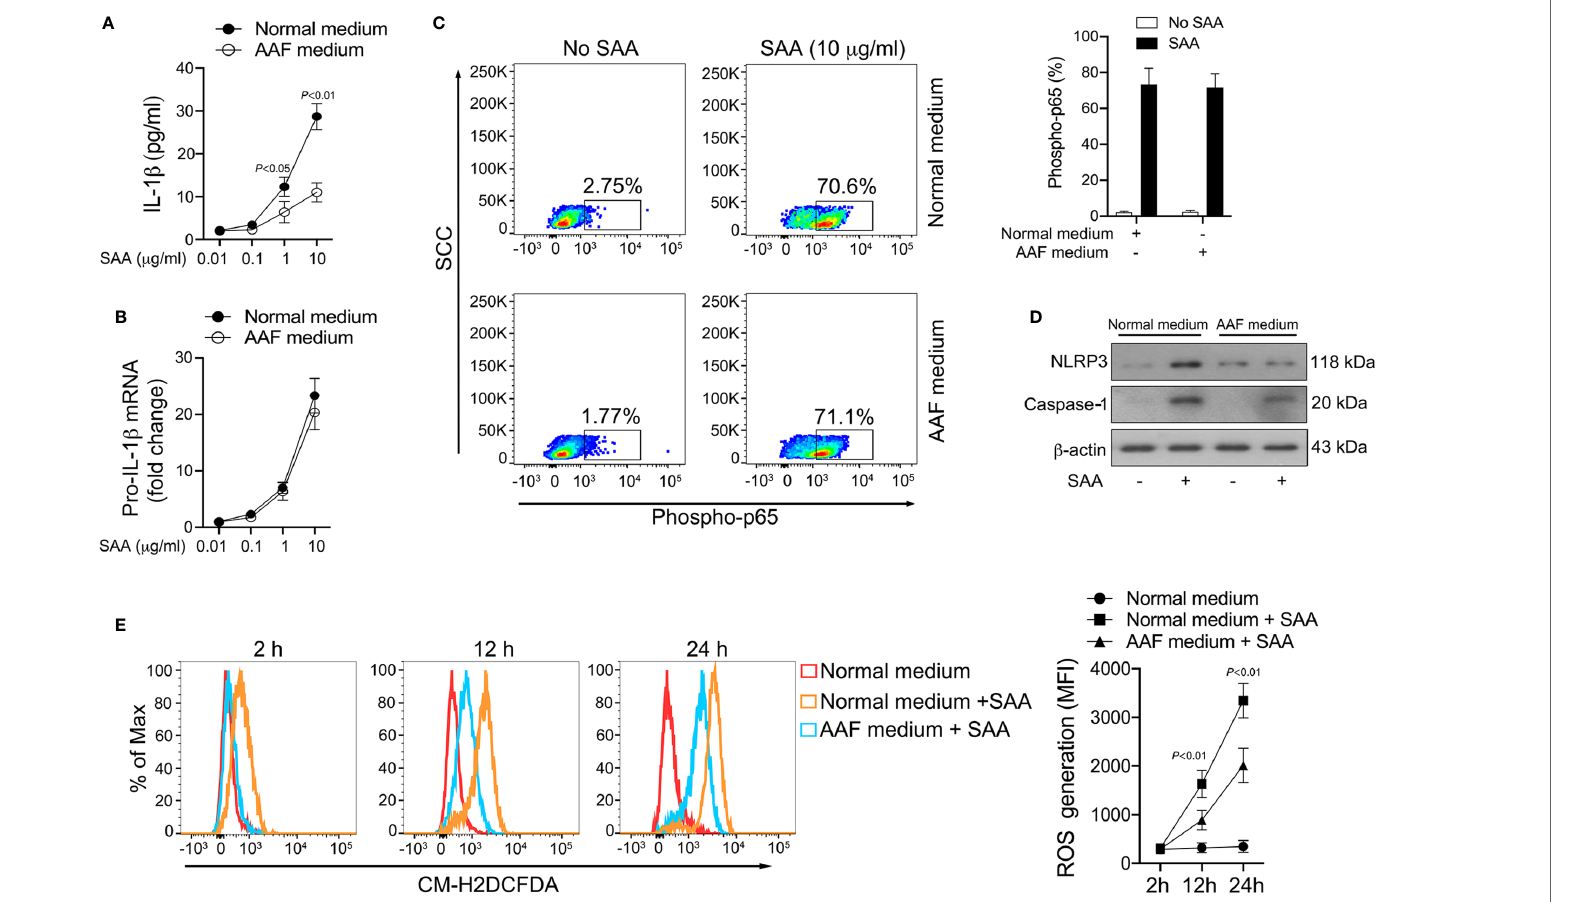
FIGURE 6 | Inhibition of SAA-induced IL-1 b by amino acid starvation. (A, B) Healthy monocytes were exposed to normal complete medium or AAF medium in the presence of SAA for 24 h IL-1 b secretion was examined by ELISA (n = 6), while pro-IL-1 b mRNA was measured by real-time RT-PCR (n = 6). (C) Healthy monocytes were exposed to normal complete medium or AAF medium for 12 h, and then were stimulated with SAA (10 m g/ml) for 15 min. The phosphorylation of NF- k B p65 was measured using fl ow cytometry. Representative dot plots and mean phospho-p65 + cells (%); mean ± SD were acquired from four independent analyses. (D) Healthy monocytes were cultured with 10 m g/ml SAA for 24 h plus normal complete medium or AAF medium. NLRP3 and active caspase-1 were examined using Western blot. Representative fi gures of four independent analyses are shown. (E) Healthy monocytes were cultured with SAA for 2 h, 12 h and 24 h in the presence of normal complete medium or AAF medium. Then the melanocytes were stained by CM- H2DCFDA, and ROS generation was tested using fl ow cytometry. Representative histograms and mean fl uorescence intensities (MFI) were acquired from four independent